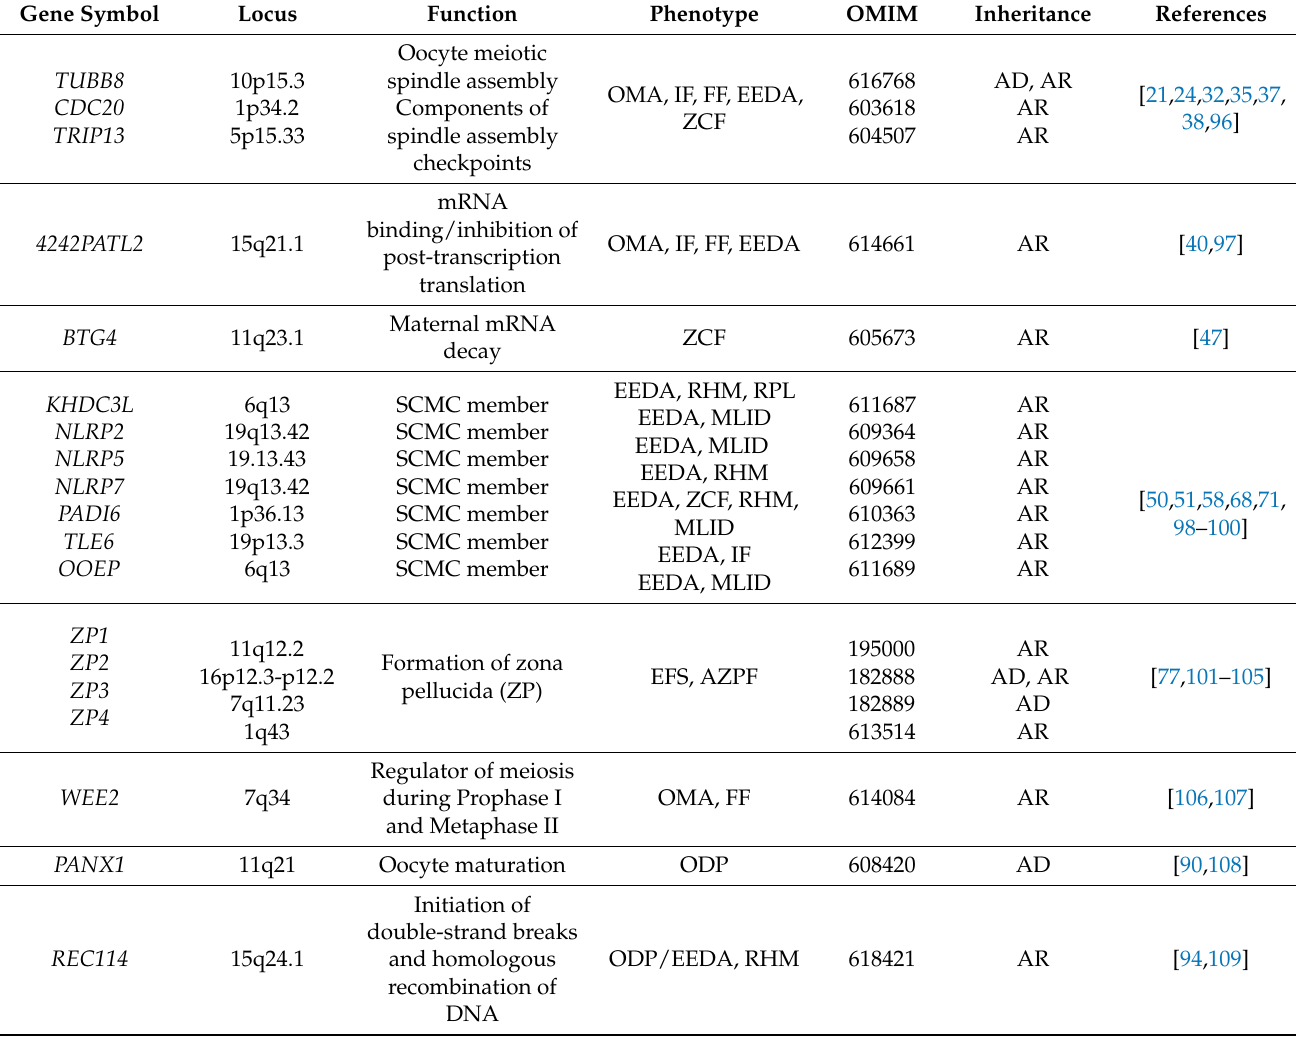
Table 1. Maternal effect genes (MEGs) and other genes affecting female fertility in